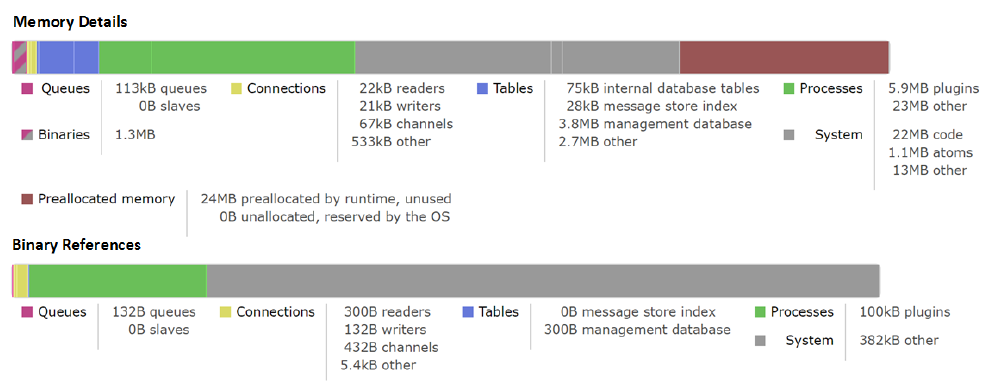
Figure 9. Memory Consumption